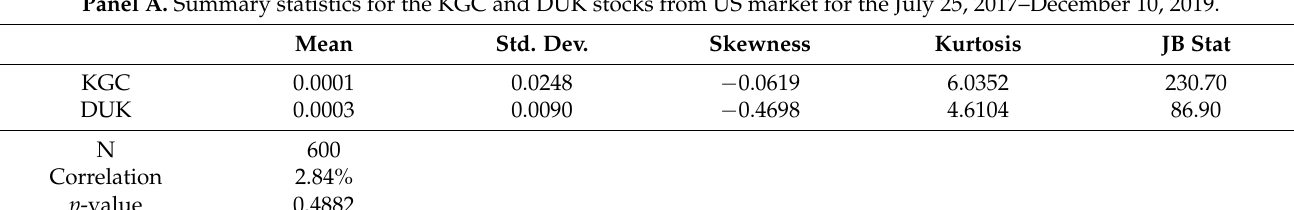
Table 1. Summary statistics for the three pairs of stocks chosen from different markets and different periods. Panel A. Summary statistics for the KGC and DUK stocks from US market for the July 25, 2017–December 10, 2019. Mean Std. Dev.